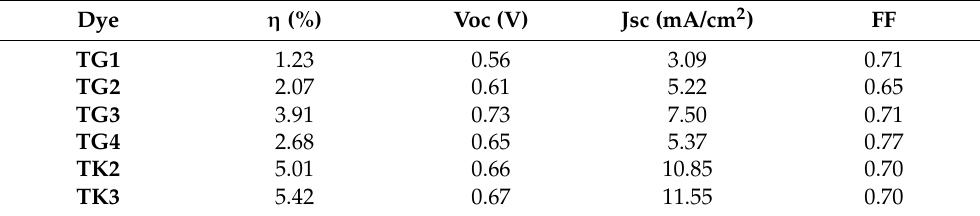
Table 4. Photovoltaic parameters for DSSCs based on dyes TG1 – 4 and TK2 – 3 .